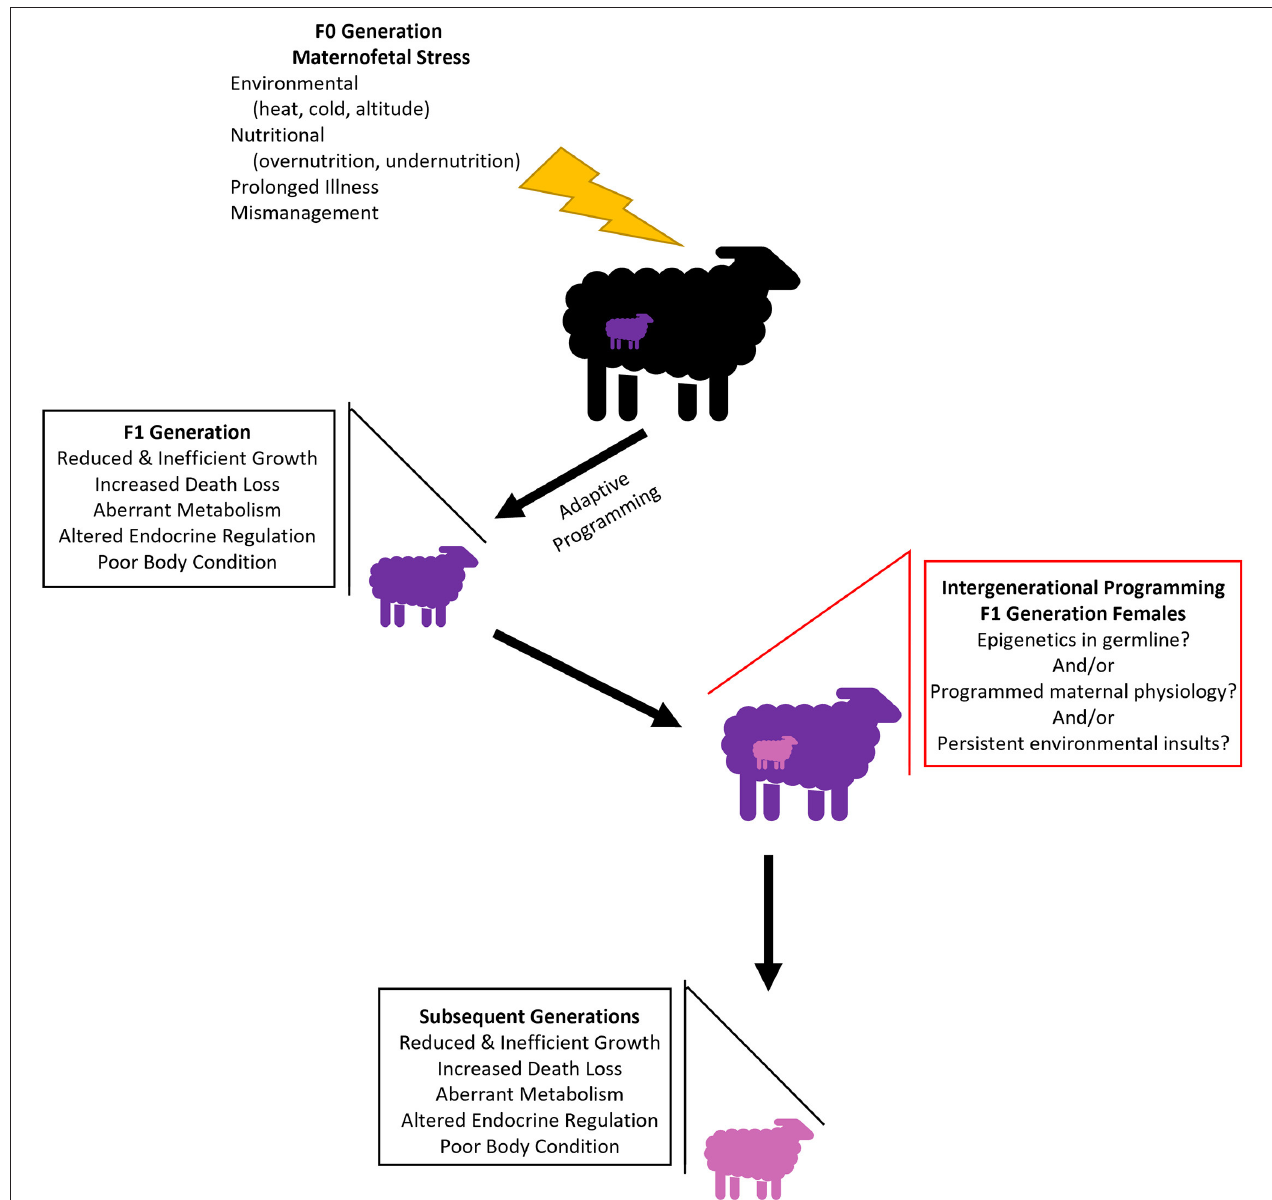
FIGURE 1 | Current proposed hypotheses of the cascade of intergenerational programming in ruminant livestock. Initial maternofetal stress results in developmental programming in the first generation. While mechanisms are not yet clear, similar phenotypes are propagated into subsequent